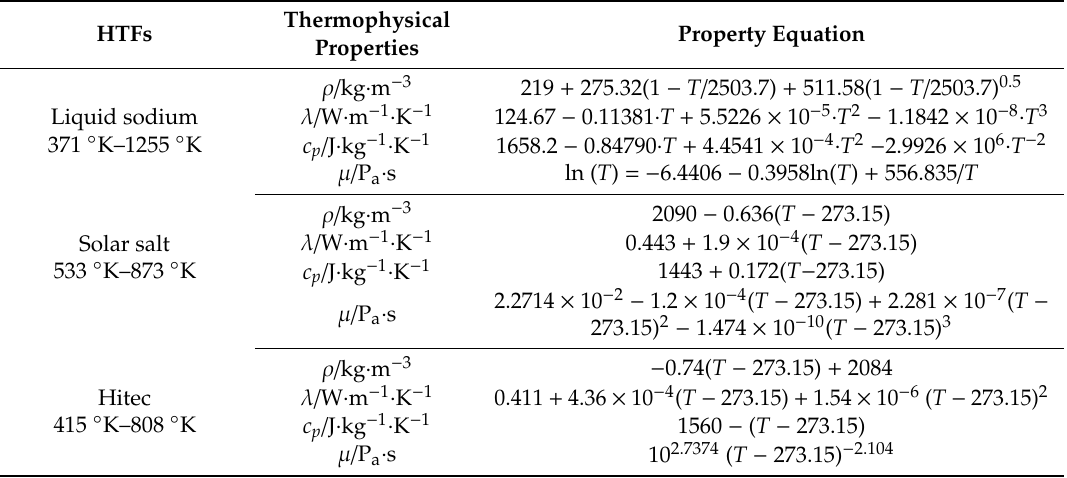
Table 1. Thermophysical properties of sodium [30], Solar salt and Hitec [7], where T is the fluid bulk temperature in